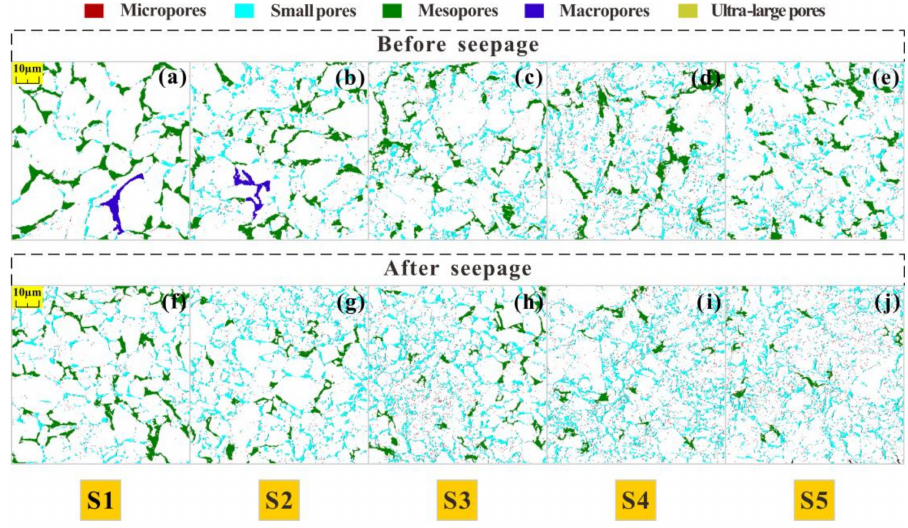
Figure 21. Pore distribution for different reclamation samples before and after seepage. ( a – e ) S1–S5 microscopic image before seepage; ( f – j ) S1–S5 microscopic image after